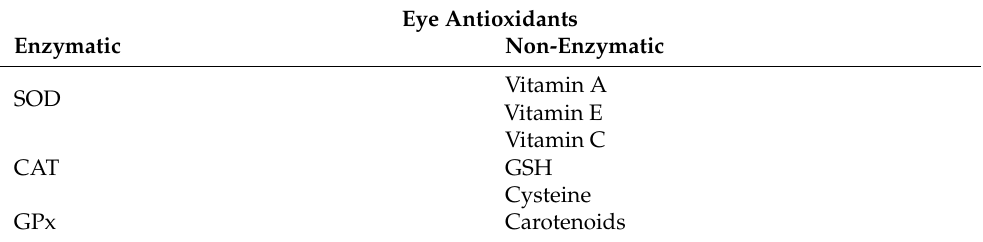
Table 1. Summary of eye